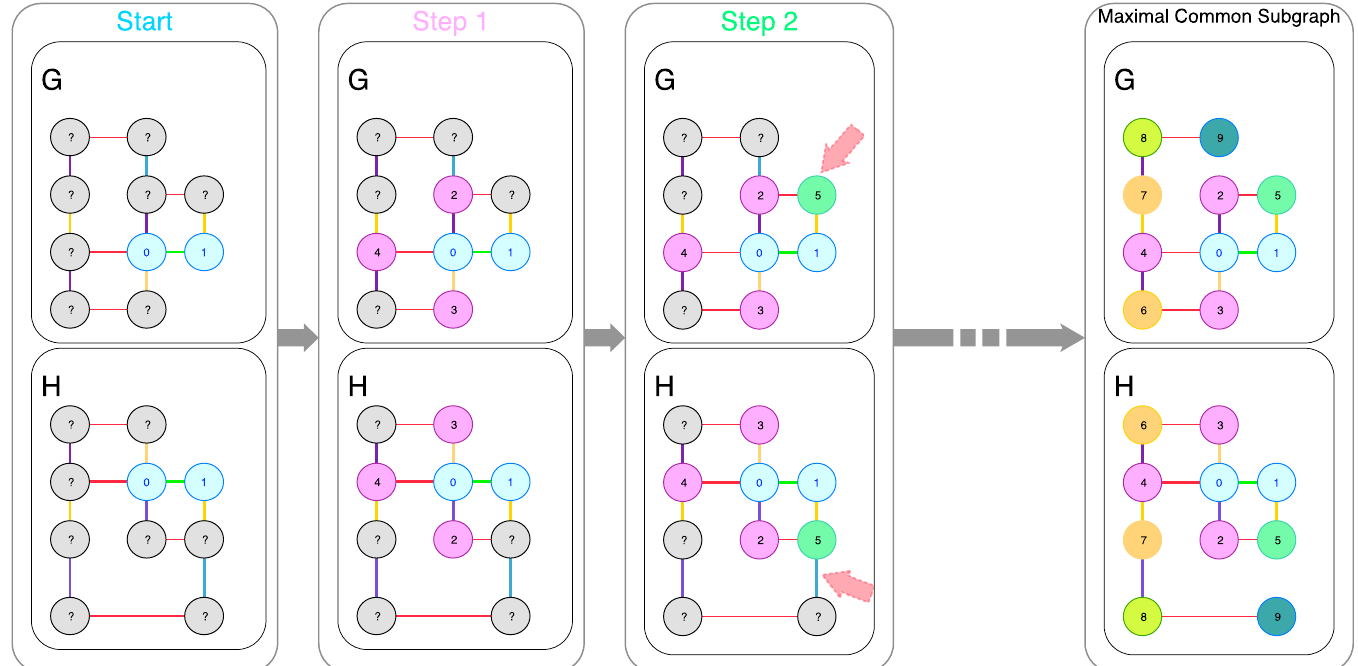
Fig 4. Illustration of the extension process. This figure illustrates the extension process from a “starting point” (here (( g 0 , h 0 ), ( g 0 , h 0 )), in blue). We first consider the neighbors of g 0 and h 0 (in purple). Thanks to the PEC, there is only one way to match them. We then consider the neighbors of g 1 and h 1 (in green). We match g 5 and h 5 but discover that their neighborhoods are not compatible. At this point the behaviours of the three algorithms differ. This discovery implies that the matching cannot be extended to cover all of G so the Graph Isomorphism and Subgraph Isomorphism will abandon it and pass on to another “starting point”. The All Maximal Common Subgraphs on the contrary will take note of this discrepancy and keep extending the matching nevertheless. This extension will output a maximal common subgraph of G and H and a new branch will be created to explore the alternative solution suggested by the discrepancy found.